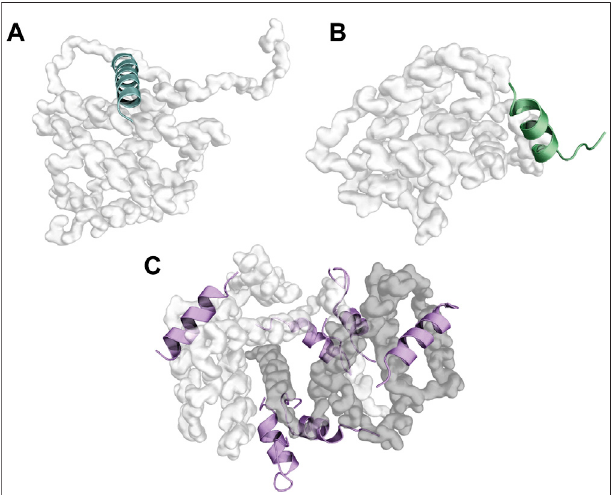
FIGURE 5 | Examples of non-canonical binding modes involving either BH3 motifs or the BH3 binding groove. Panel (A) displays a helix-stabilized version of IM bound to a new interaction site on BAX (PDB ID: 2K7W), while panel (B) illustrates the binding of the non-BH3 interactor p73-TAD on BCLXL(PDBID:6IJQ).Finally,panel (C) showsthebindingoftheBH3ofTPT1 to BCLXL (PDB ID: 4ZD9). The BH3 peptides of TPT1 contacting BCLXL